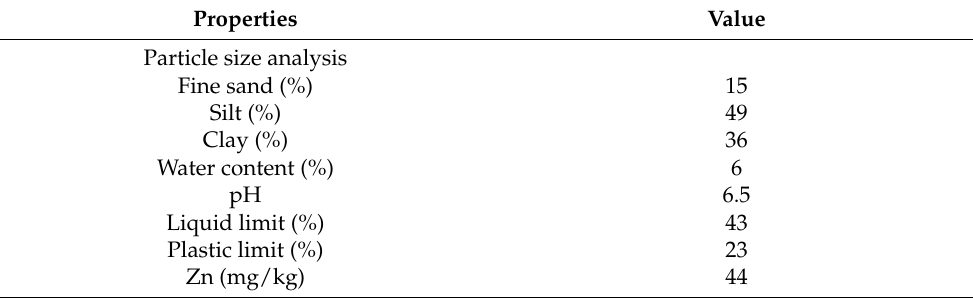
Table 1. Characteristics of clay powder used in this study.